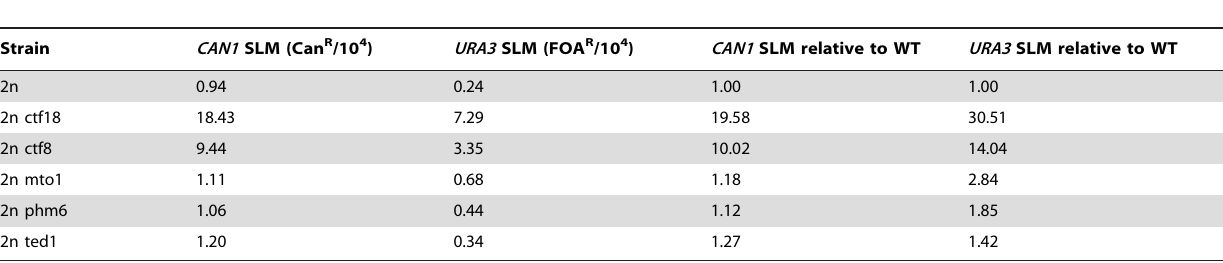
Table 2. SLM levels in diploid cells lacking CTF18 , CTF8 , MTO1 , PHM6 and TED1 gene products.